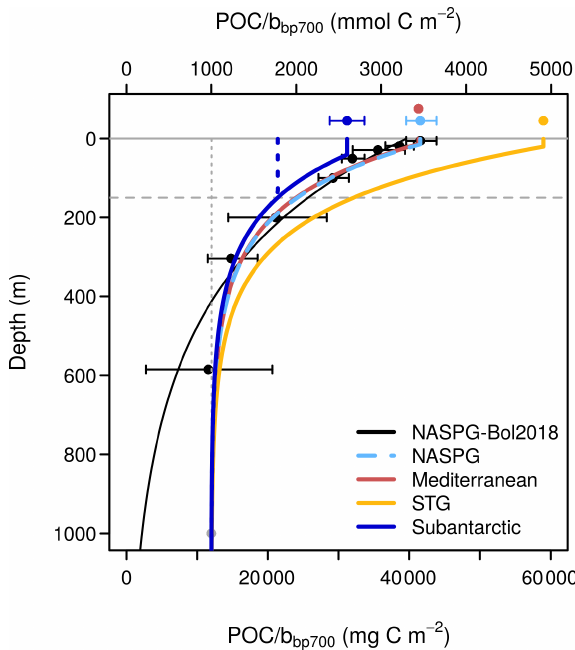
Figure 2. Empirical model used to convert the backscattering co- efficient at 700nm ( b bp700 ) to particulate organic carbon (POC). Black dots and error bars show the dataset of Cetini´c et al. (2012) as binned by Bol et al. (2018). The black curve shows the expo- nential fit of Bol et al. (2018) to the Cetini´c dataset. The dashed light-blue curve shows our fit to the same dataset (NASPG: North Atlantic subpolar gyre), forced to converge to a nonzero minimum value at depth. The remaining curves show similar functions with the same exponential slope ( b = − 6 . 57) as the NASPG fit, but with different surface values derived from the following studies: Loisel et al. (2001) for the Mediterranean Sea; Stramski et al. (2008) for the ensemble of subtropical and tropical areas excluding equato- rial upwellings (STG); and Johnson et al. (2017) for the Southern Ocean (subantarctic). The depth of the homogeneous surface layer, z surf , biome in Eqs. (1) and (2), corresponds to the 5% quantile of the climatological MLD in summer in a given biome: 15m in the NASPG, 14m in the MED, 21m in the STG, and 41m in the SO. The dotted green line, shown for the SO case only, illustrates the behavior of the algorithm for a hypothetical MLD of